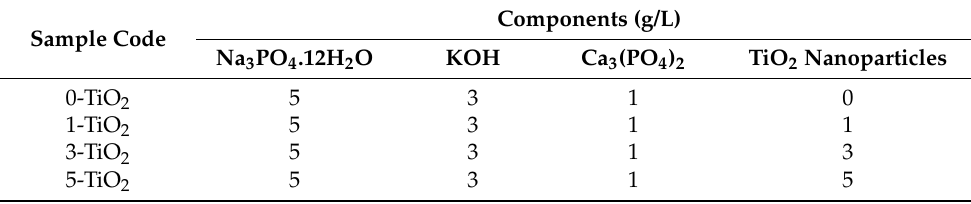
Table 1. The chemical composition of the PEO process electrolytes for each sample code. Sample